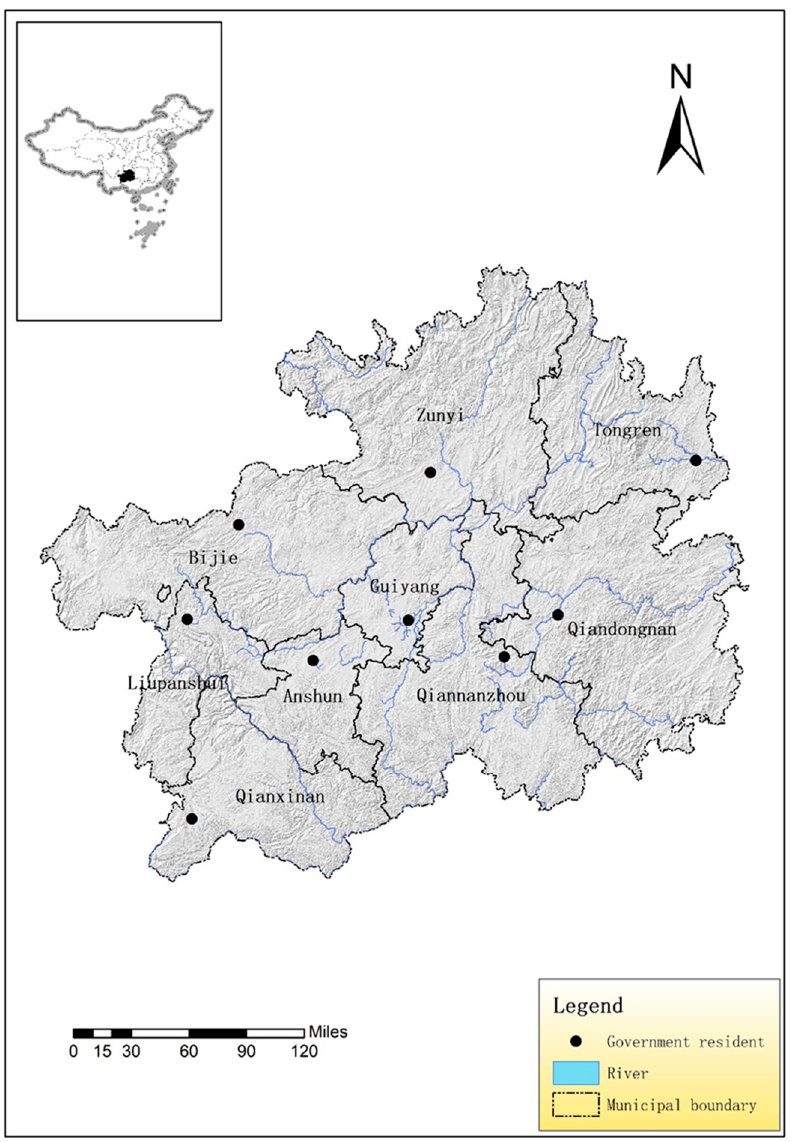
Figure 2. Location and range map of the study area .